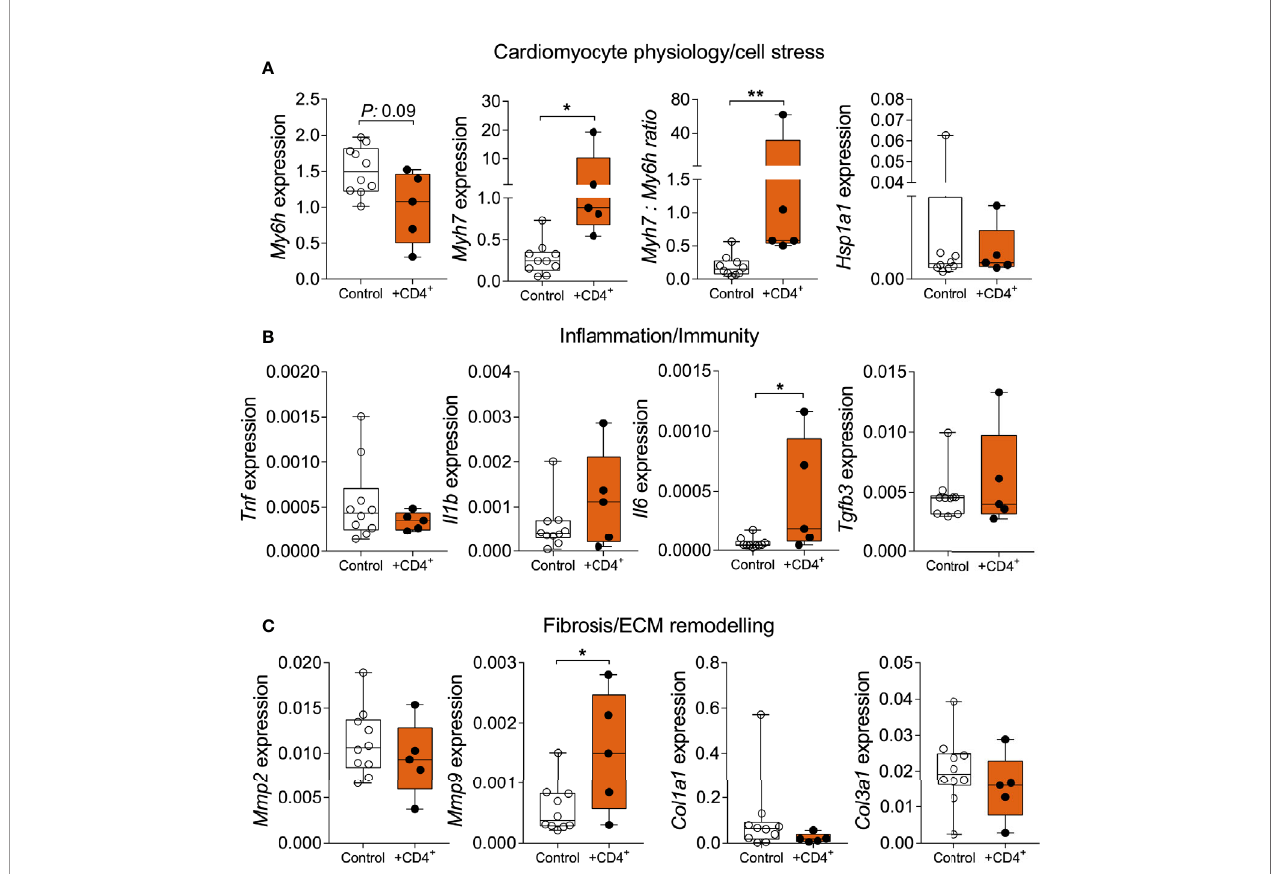
FIGURE 4 | Senescent-like CD4 + T cells promote alterations in myocardial gene expression compatible with physiological aging. Relative myocardial mRNA levels of transcripts related to cardiomyocyte stress (A) , in fl ammation (B) , and extracellular remodeling (C) . Control group: Naïve NSG-DR1 mice. CD4 + group: NSG-DR1 mice transplanted with human CD4 + T cells. The bar graphs display the group mean values, the SEM and the distribution of each individual value. Statistical tests: Mann-Whitney. ** P < 0.01 and * P <